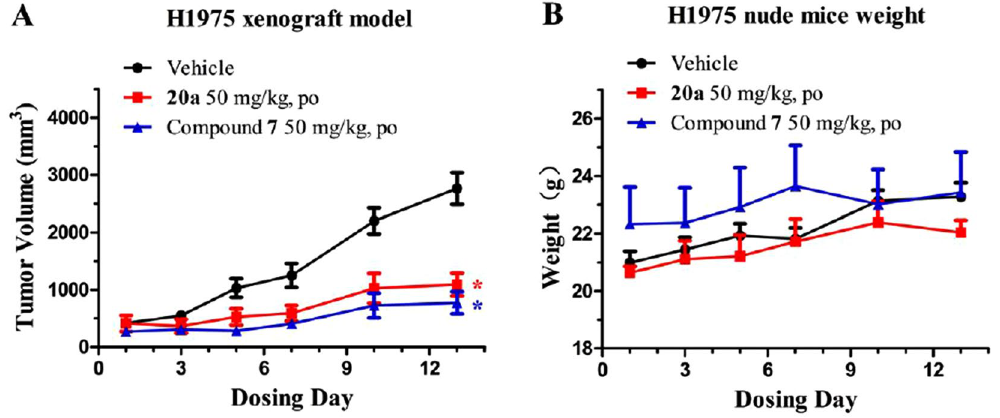
Figure 7. Preliminary in vivo antitumor efficacy of compound 20a against H1975 NSCLC xenograft mouse model. H1975 cells were implanted as described in Methods. Compounds 20a and 7 were administered orally at a concentration of 50 mg/kg/day for consecutive 14 days starting from day 0. H1975 xenograft mouse model tumor volumes ( A ) and body weights ( B ) were recorded every two or three days. All values represent mean ± SEM. The tumor growth inhibition (TGI, %) was measured on the final day of the treatment (drug- treated group versus the vehicle control), where the asterisk ∗ represents P < 0.05 (Student’s t test) compared to the vehicle